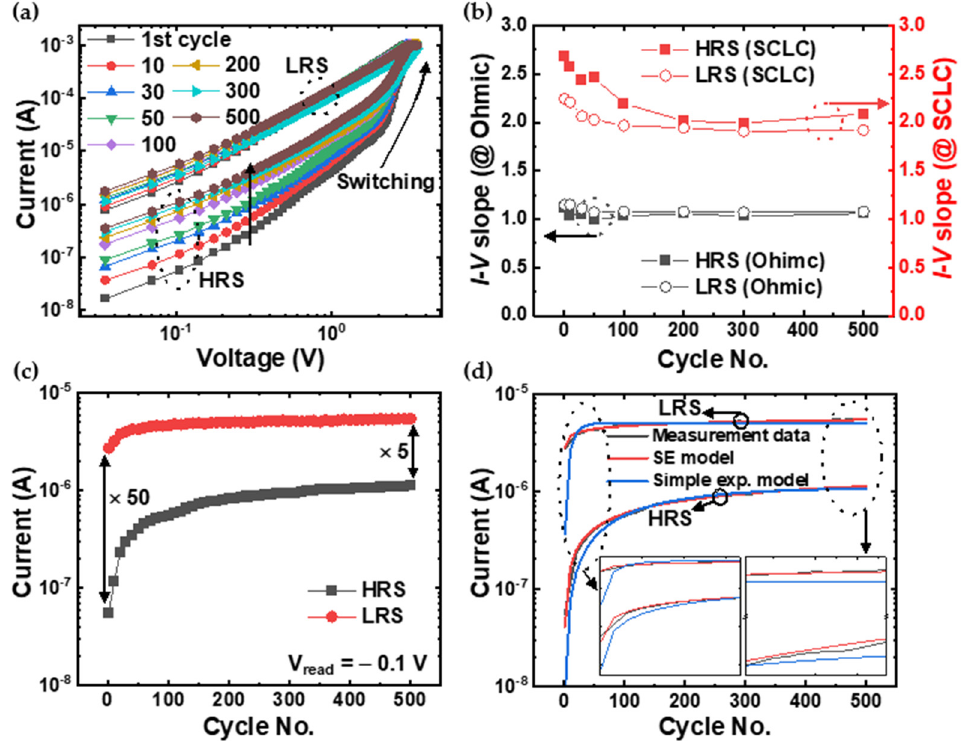
Figure 3. ( a ) The double-logarithmic plot of the I–V characteristics (HRS to LRS) for 500 DC cycles. ( b ) The change in slopes of the I–V curves in Ohmic (black) and the SCLC (red) region according to the RS cycle. ( c ) The endurance characteristic in both the HRS and LRS at the read voltage of 0.1 V. The initial on/off ratio of about 50 decreases to 5 after 500 DC cycles. ( d ) The fitting results for simple exponential (blue line) and SE function (red line). Insets show enlarged graphs at the beginning (left) and end (right) of the curves.